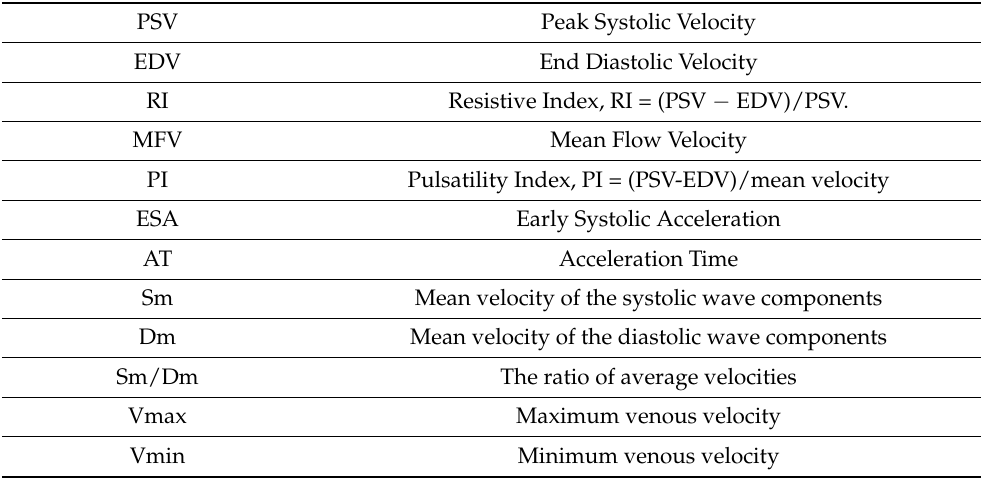
Figure 1. Using the B-scan mode to identify ocular structures. Color Doppler is applied to record the Doppler waveforms: ( A ) Ophthalmic Artery, ( B ) Central Retinal Artery, ( C ) Temporal Short Posterior Ciliary Arteries. Table 1. Parameters calculated by CDI.